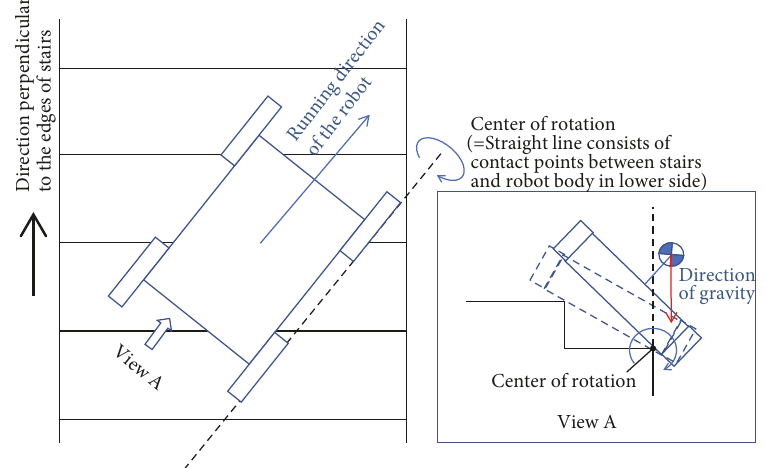
Figure 5: Falling sideward caused by direction error.